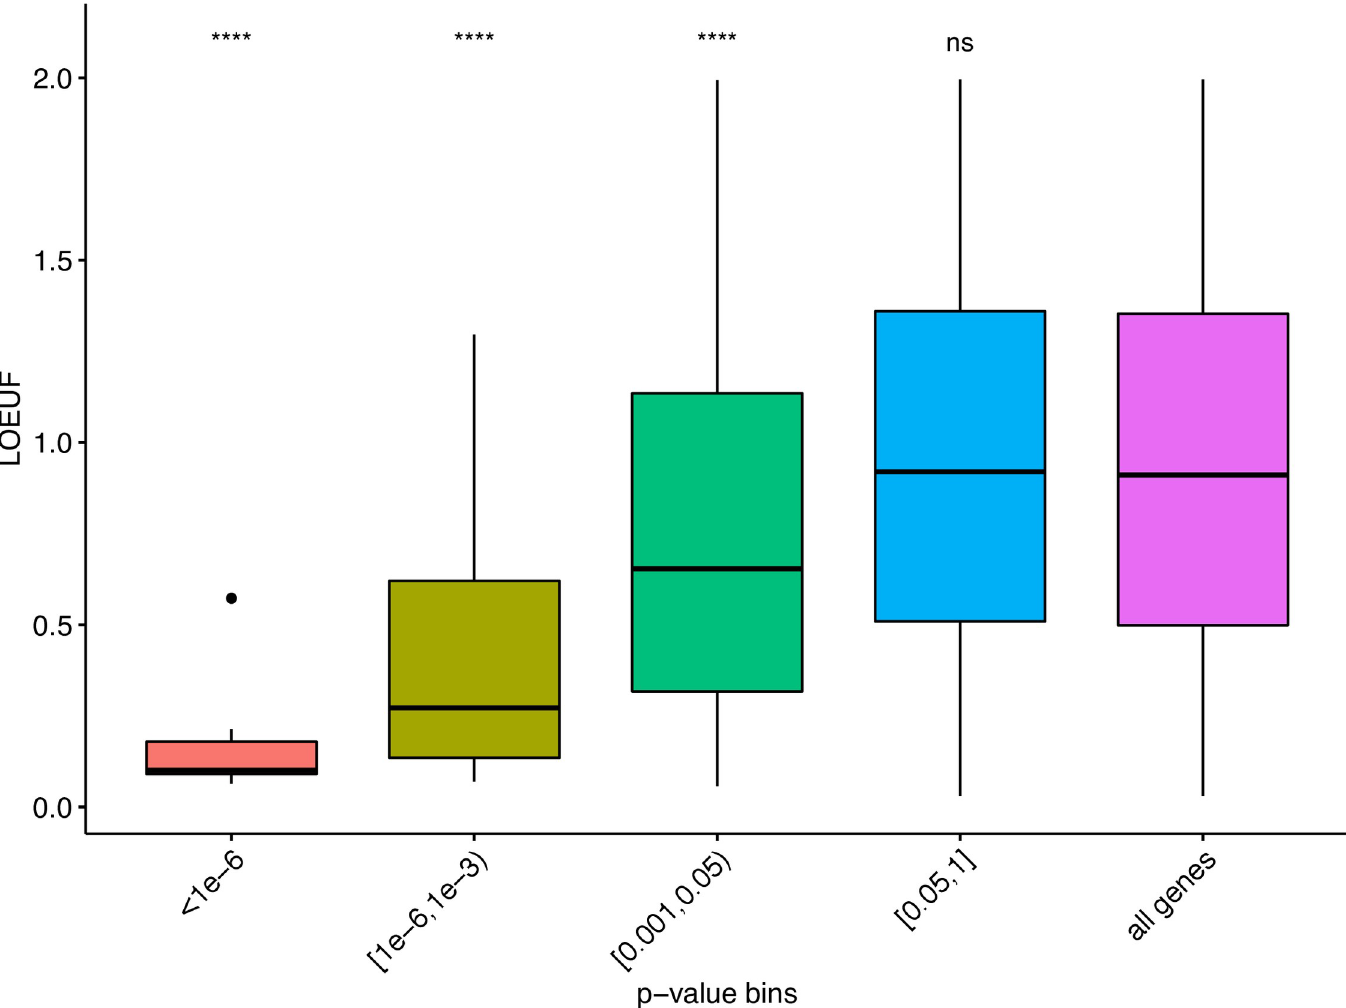
Fig 4. Comparison of the distribution of LOEUF metric at different level of significance of nsDNV-enriched genes. X-axis denotes the P-values from the DNV analysis (binned). Y-axis denotes the o/e LOF ratio upper bound fraction (LOEUF). All groups were compared against the LOEUF distribution of all protein-coding genes (purple). Differences between the distributions were tested using a two-sided Wilcoxon rank sum test. ���� : P < 0.0001, ns: